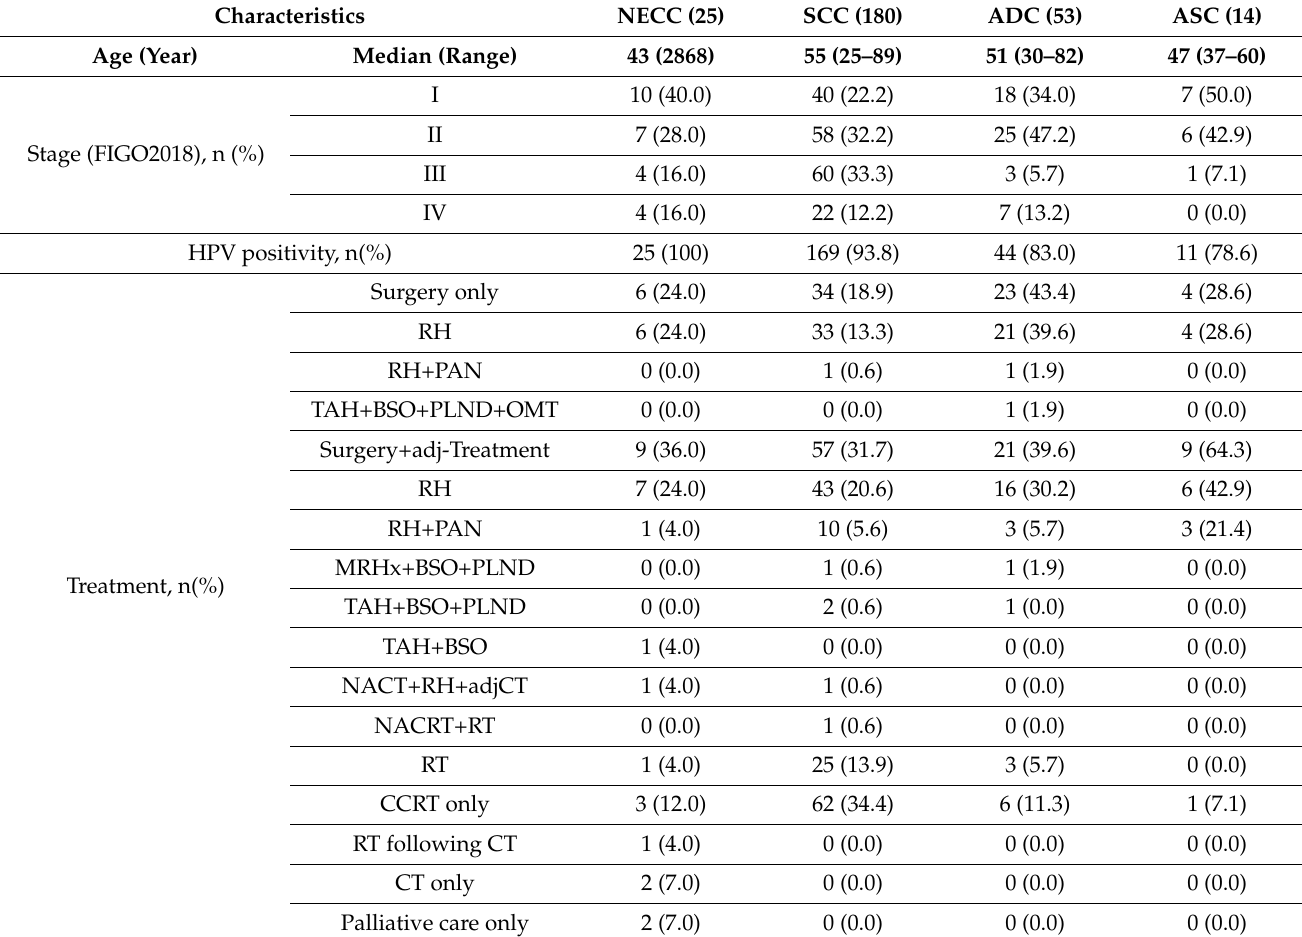
Table 1. Clinicopathological characteristics of 272 patients with cervical cancers.